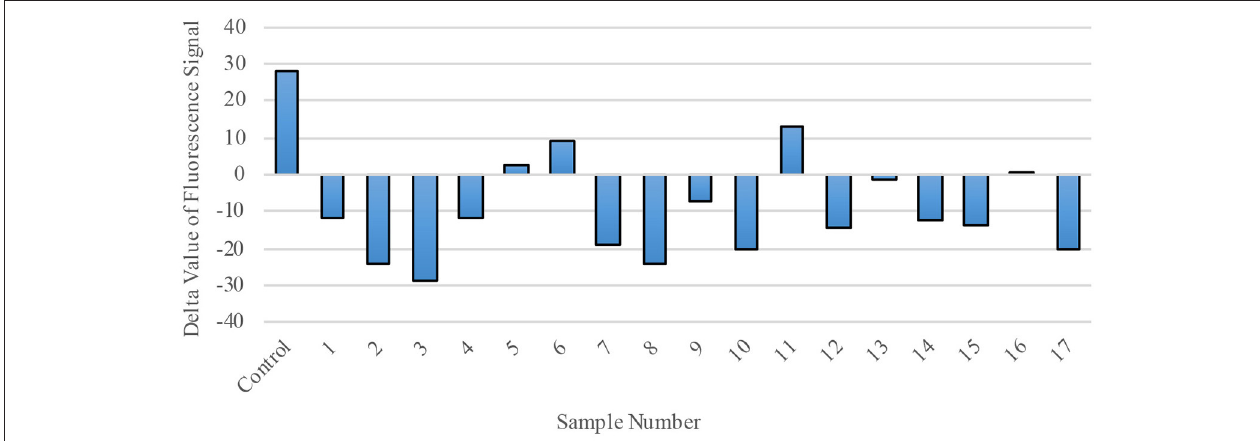
FIGURE 6 | RdRp Enzymatic Activity is blocked by polio-immune serum. RdRp polymerase activity was evaluated by fluorescence staining of de novo synthesized RNA. In the presence of diluted serum (1:1800), RdRp’s activity is inhibited. Each bar represents one serum sample (17 randomly-selected samples compared to a